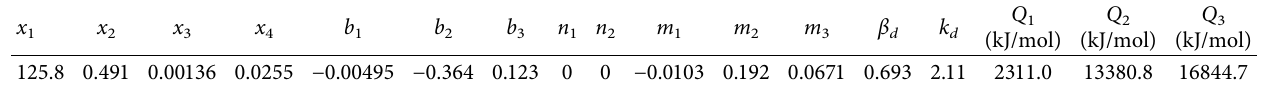
Table 1: The value of parameters of the dynamic recrystallization